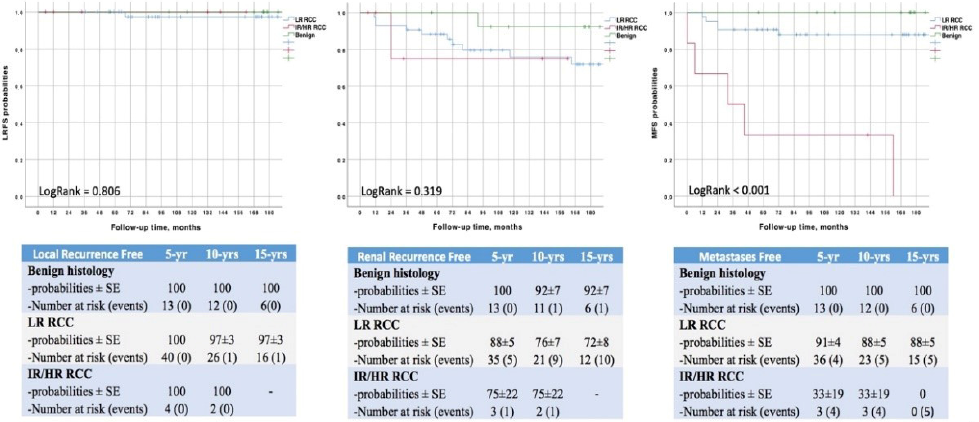
Figure 2. Probabilities of local recurrence, renal recurrence and metastasis, according to MCRSS/UCISS stratification